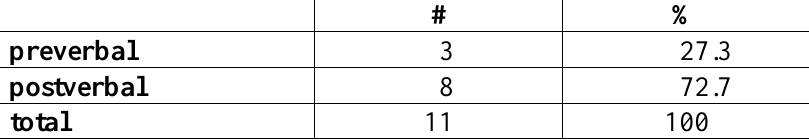
Table (11): Positioning of usted in direct non-cleft argumental wh -interrogatives Unlike in the case of non-argumental wh -interrogatives, a fair number of informants (a total of 5) produced wh SV order along with wh VS order with argumental wh -interrogatives comprising subject elements attested both pre- as well as postverbally (cf. Table